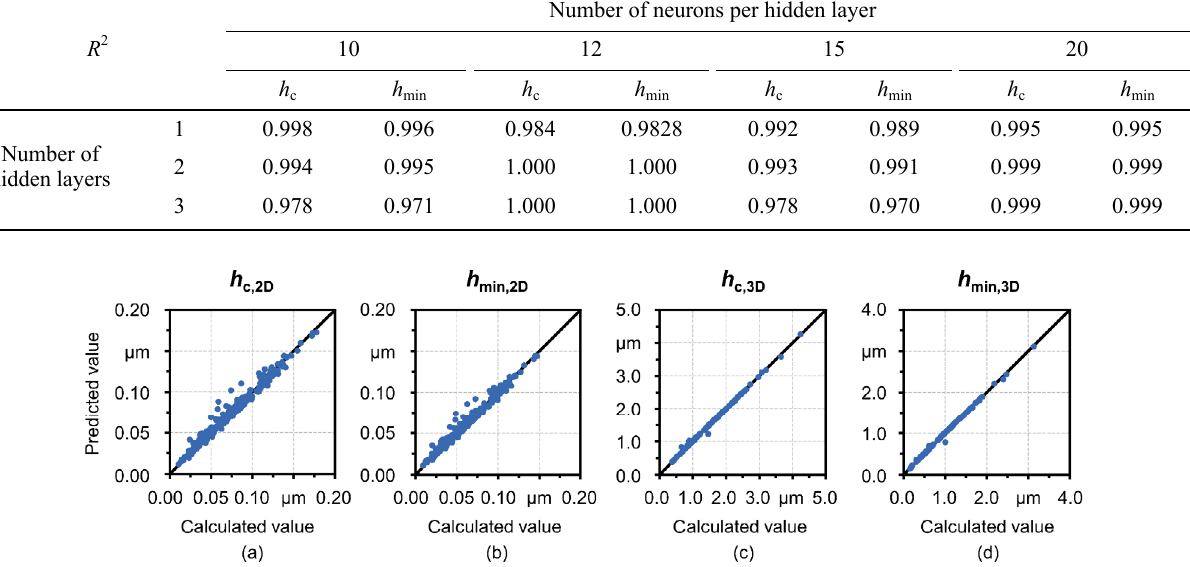
Fig. 8 Predicted versus calculated values (testing data) of the central and minimum film thicknesses for the (a, b) infinite 2D line and (c, d) 3D circular point contacts using an ANN with 12 neurons in each of the two hidden Table 9 Coefficients of determination of the prediction for the Table 10 Coefficients of determination of the prediction for the central and minimum film thicknesses for the infinite 2D line central and minimum film thicknesses for the infinite 2D line and and 3D circular point contacts against testing data using an ANN 3D point contacts using an ANN with 12 neurons in each of two with 12 neurons in each of two hidden layers after training with hidden layers after training with hyperbolic tangent, sigmoid and the original EHL inputs, the non-dimensional parameters U , G , identity activation functions. W , or M , L . EHL 2D R 2 line contact